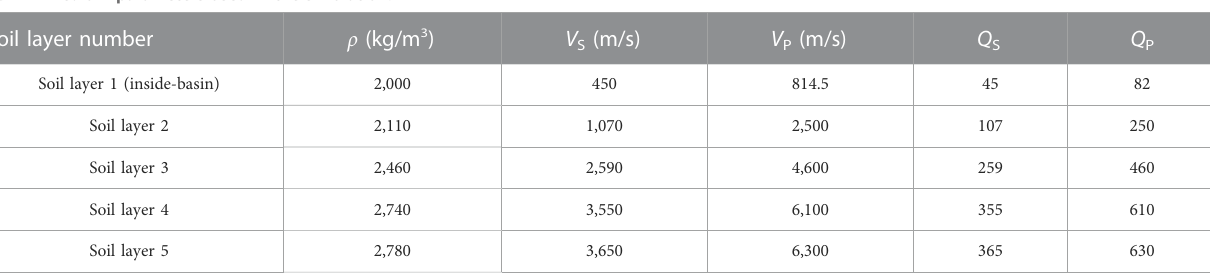
TABLE 1 Medium parameters used in the